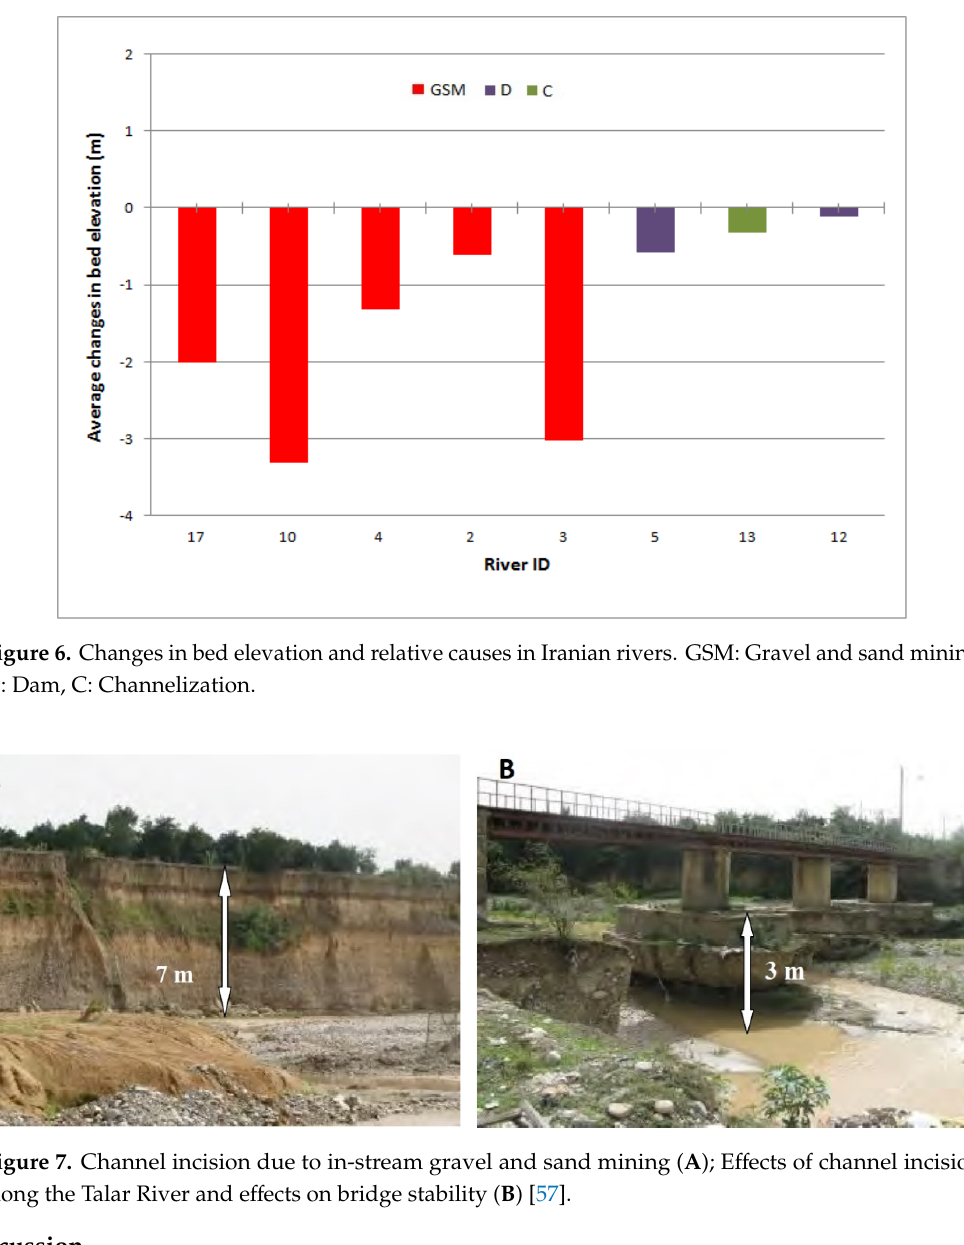
Figure 7. Channel incision due to in-stream gravel and sand mining ( A ); Effects of channel incision along the Talar River and effects on bridge stability ( B ) [57].